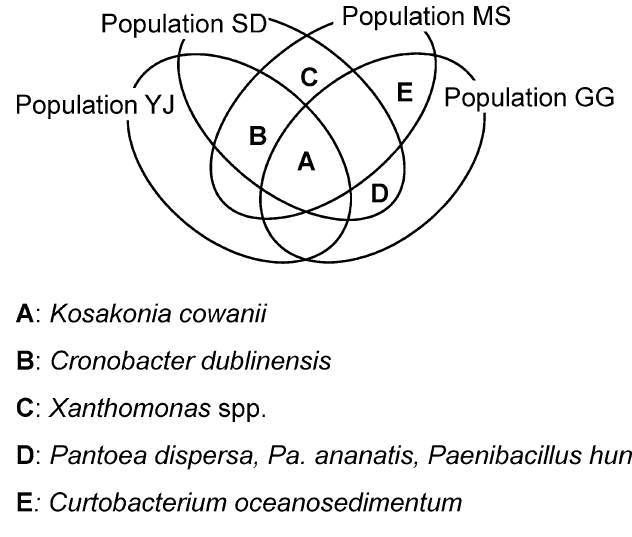
Figure 3. Venn diagram of the shared isolates among the plant populations.